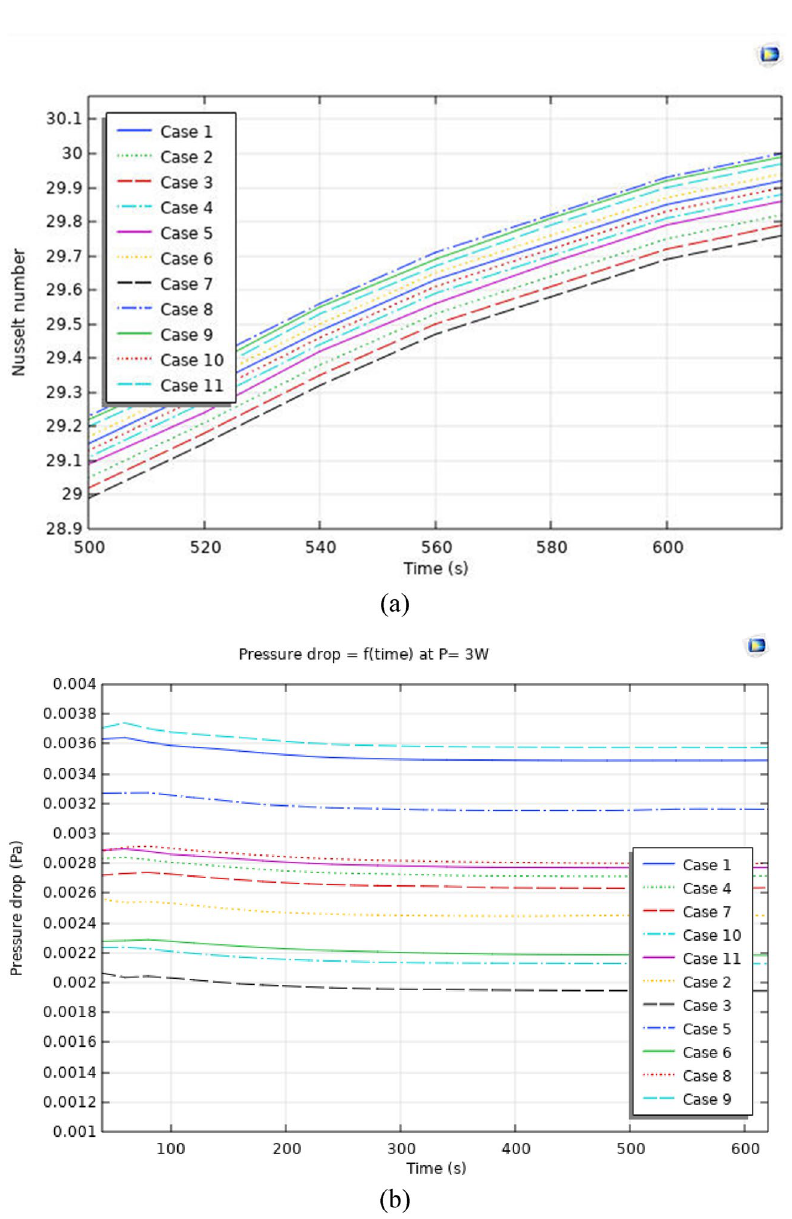
Figure 14. ( a ) Nusselt number ( b ) Pressure drops graphs for P = 3 W for all designed